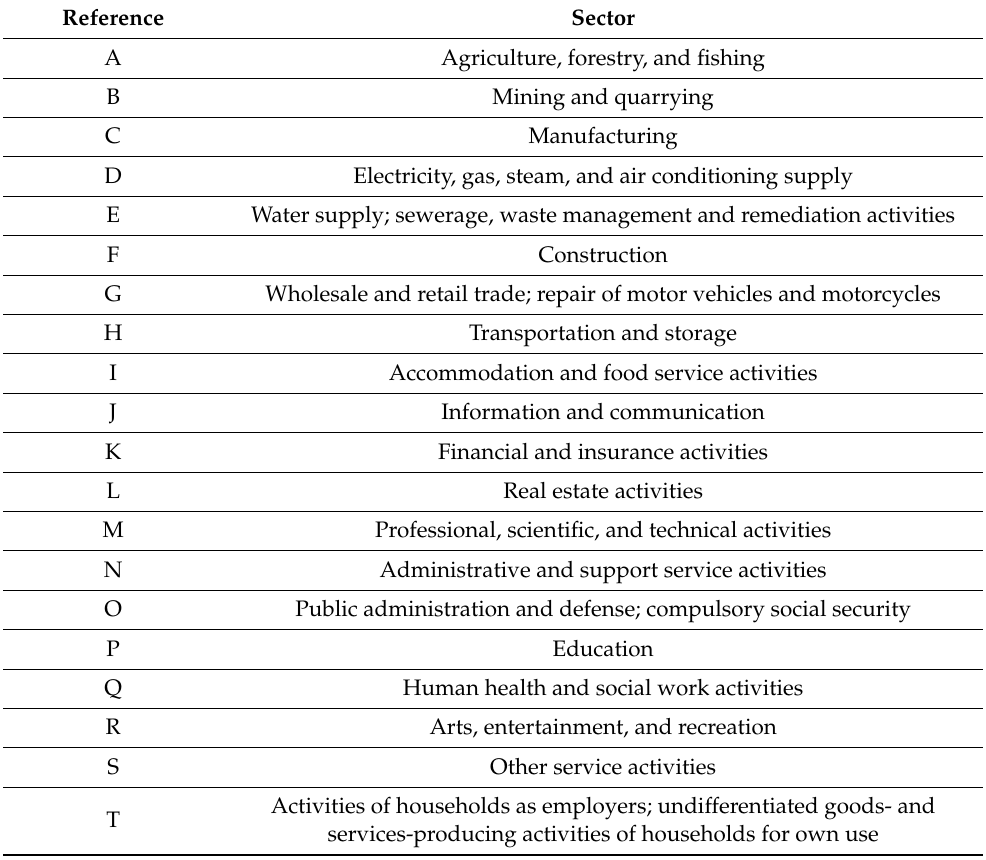
Table 1. Productive sectors of the input–output tables used.